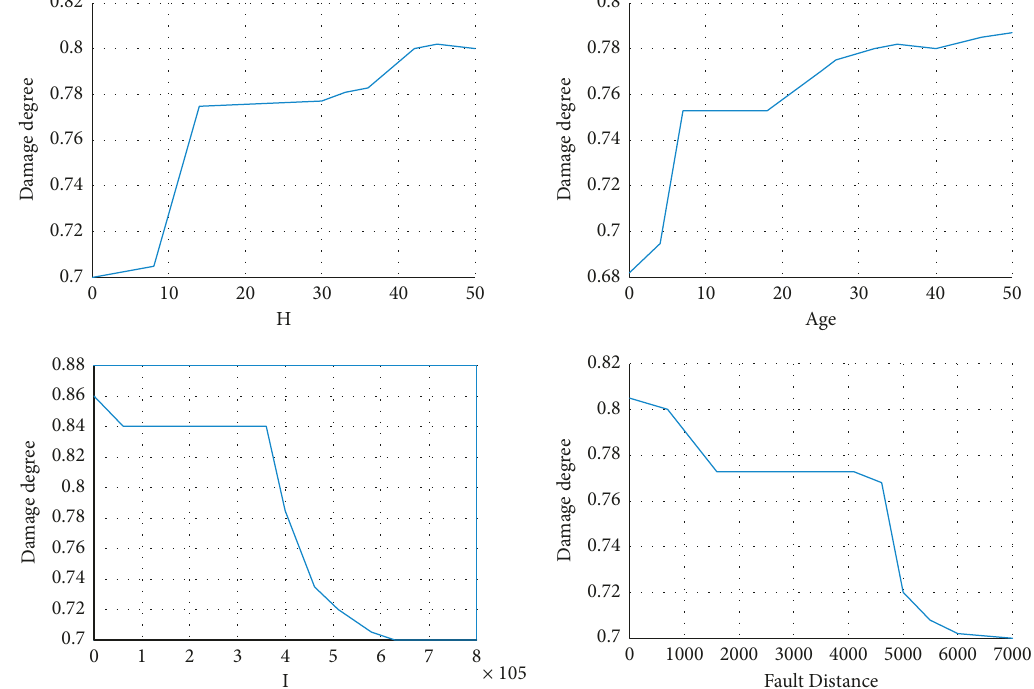
Figure 6: Input parameters changes effects on the degree of damage to the structure.